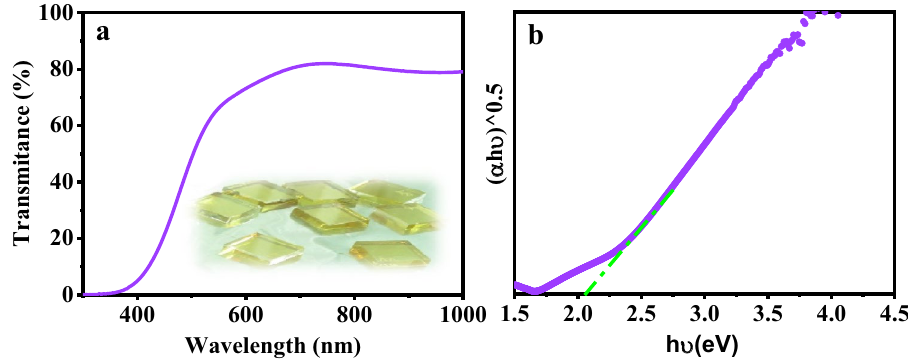
Figure 4. ( a ) Optical transmittance spectra and ( b ) indirect bandgap of In 2 S 3 layers.